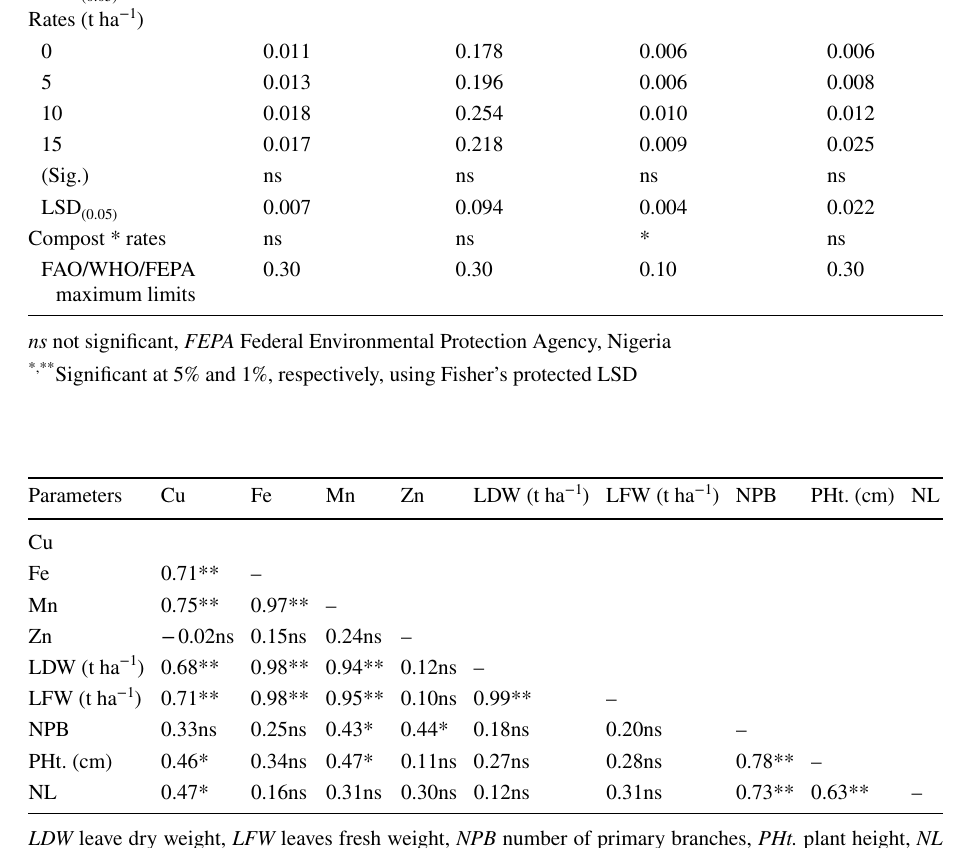
by Corchorus olitorius leaves grown on soil amended with composted kitchen waste and